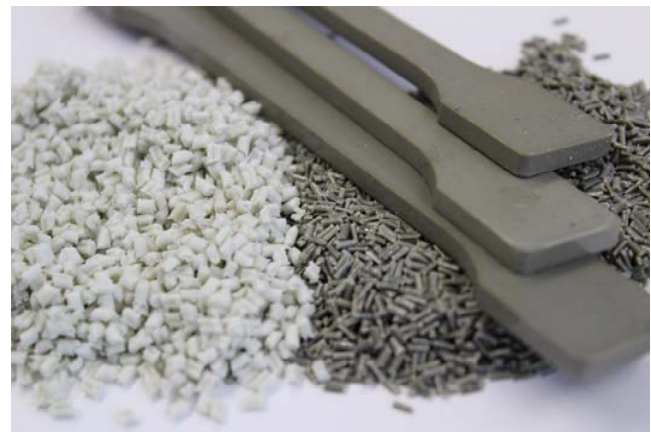
Figure 7. Recovered PBT material from CreaSolv ® Process after solvent recovery: PBT ‐ blend (left) and